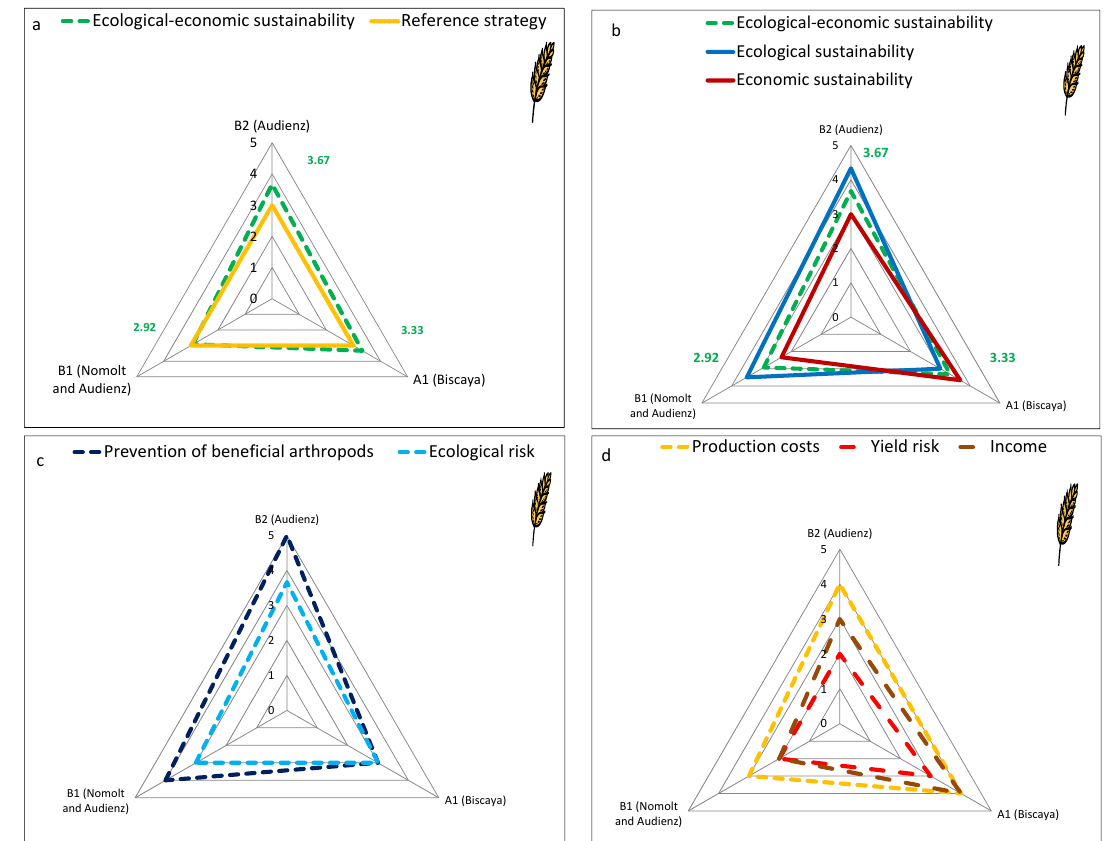
Figure 2. Results of the sustainability assessment of different plant protection strategies for the control of the cereal leaf beetle compared to the reference strategy using Nomolt (teflubenzuron) and Biscaya (thiacloprid). 1 = Much worse than RS; 2 = Worse than RS; 3 = Similar to RS; 4 = Better than RS; 5 = Much better than RS; RS = Reference